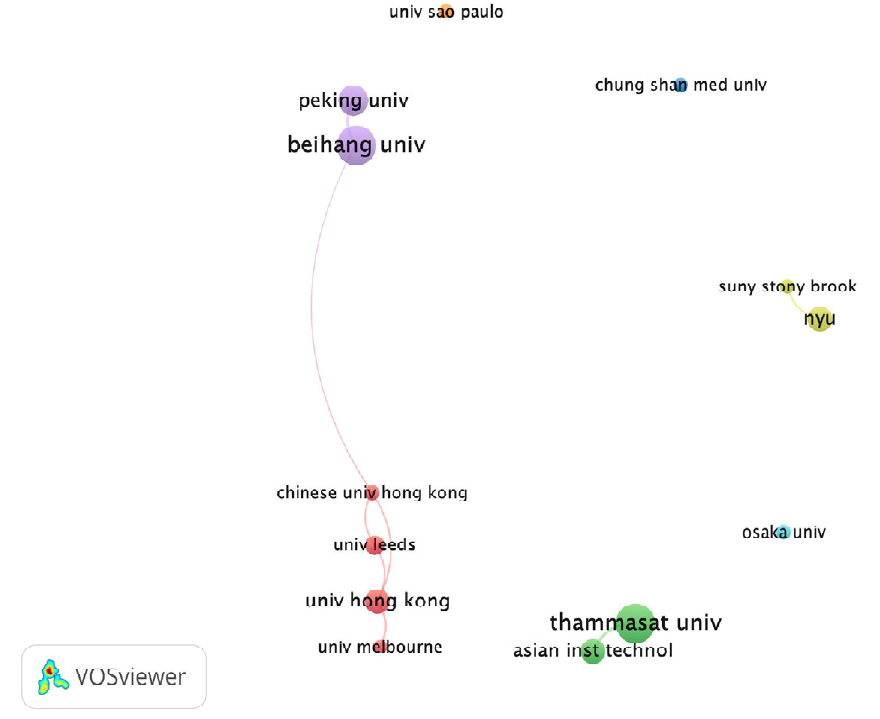
Figure 3. The co ‐ authorship network of affiliations published at a minimum of three articles in net ‐ work visualization.